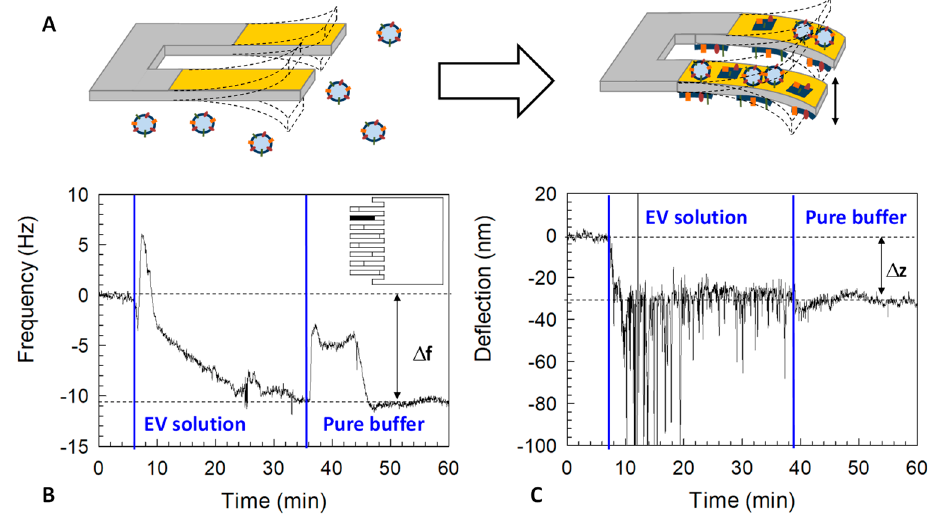
Figure 4. Simultaneous MCs experiments in static and dynamic mode. ( A ) Scheme of the interaction between MCs and EVs; ( B ) representative MC frequency signal due to the interaction of EVs and MC surfaces; ( C ) absolute deflection signal of the MC of panel B.